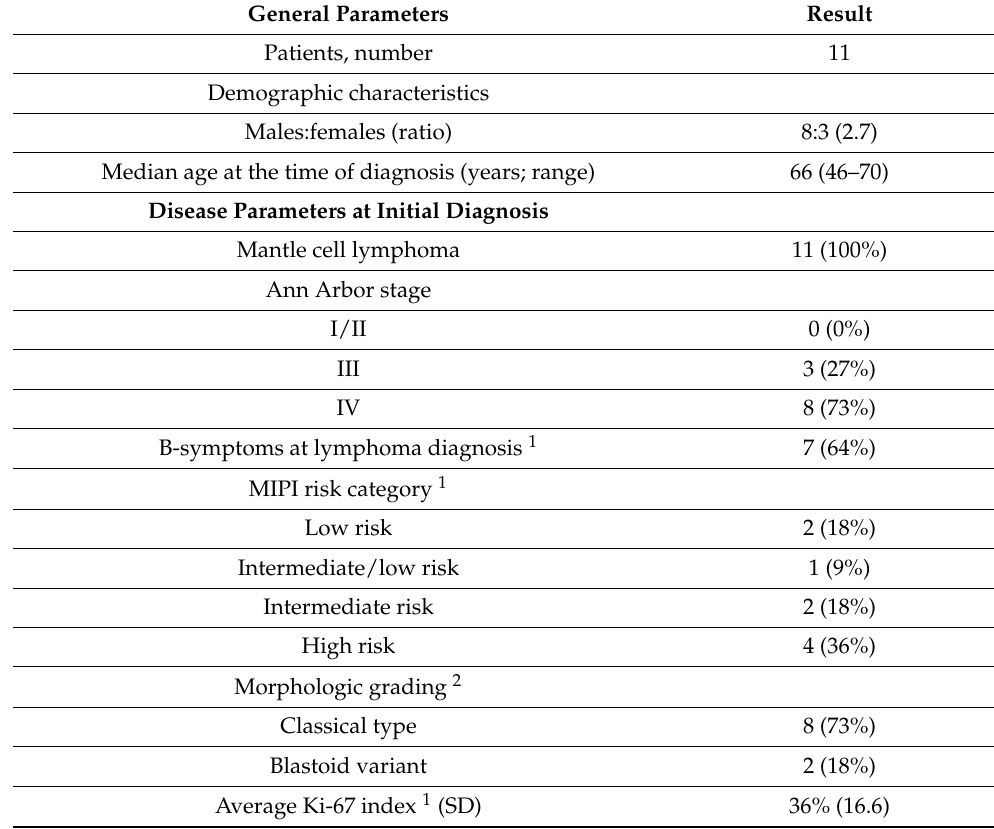
Table 1. Clinical characteristics of the